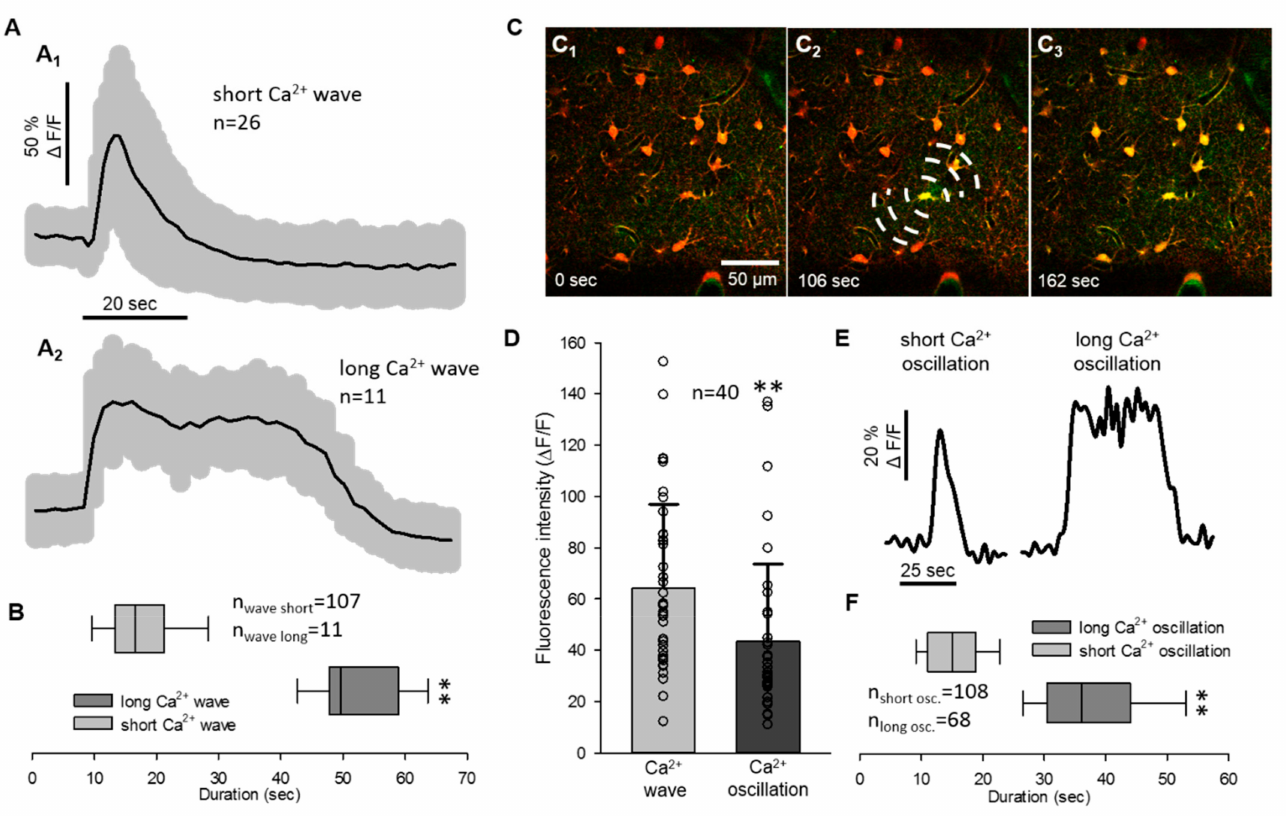
Figure 2. Quantitative analysis of the spreading depolarization related astrocyte Ca 2+ waves and oscillations. ( A ) Traces of SD related short and long Ca 2+ waves (mean ± st.dev.). ( B ) Duration of SD related Ca 2+ waves. ( C ) Images represent Ca 2+ changes (Fluo-4 AM, green) of astrocytes (SR101, red) with the propagation of SD. Dashed lines in D 2 indicate the origin of SD and direction of propagation. Note that images ( C 1 – C 3 ) represent a long Ca 2+ wave with a focal SD origin in the field of view. ( D ) Peak fluorescence maxima ( ∆ F/F) of astrocyte Ca 2+ waves and oscillations derived pairwise from 40 cells. ( E ) Representative traces of short and long Ca 2+ oscillations after SD. ( F ) Duration of the SD related Ca 2+ oscillations. Images were taken at a cortical depth of 55–75 µ m. Data are given as mean ± st.dev. Statistical analysis relied on a Mann-Whitney Rank Sum Test ( B , F ) and two-tailed paired T test ( D ); p < 0.01